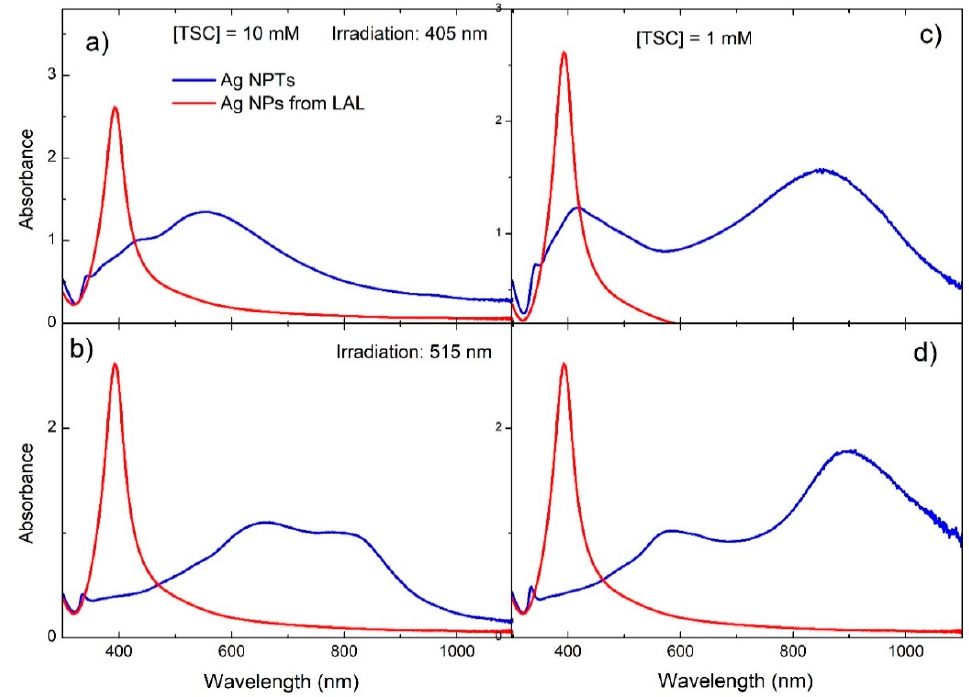
Figure 11. Absorption spectra from Ag NPTs produced by LAL followed by LED monochromatic irradiation (blue lines) and Ag NPs from LAL (red lines). ( a , b ) TSC concentration, 10 mM; ( c , d ) TSC concentration, 1 mM; ( a , c ) irradiation at 405 nm; ( b , d ) irradiation at 515 nm. Adapted from ref. [25]. Copyright 2020 American Chemical Society.